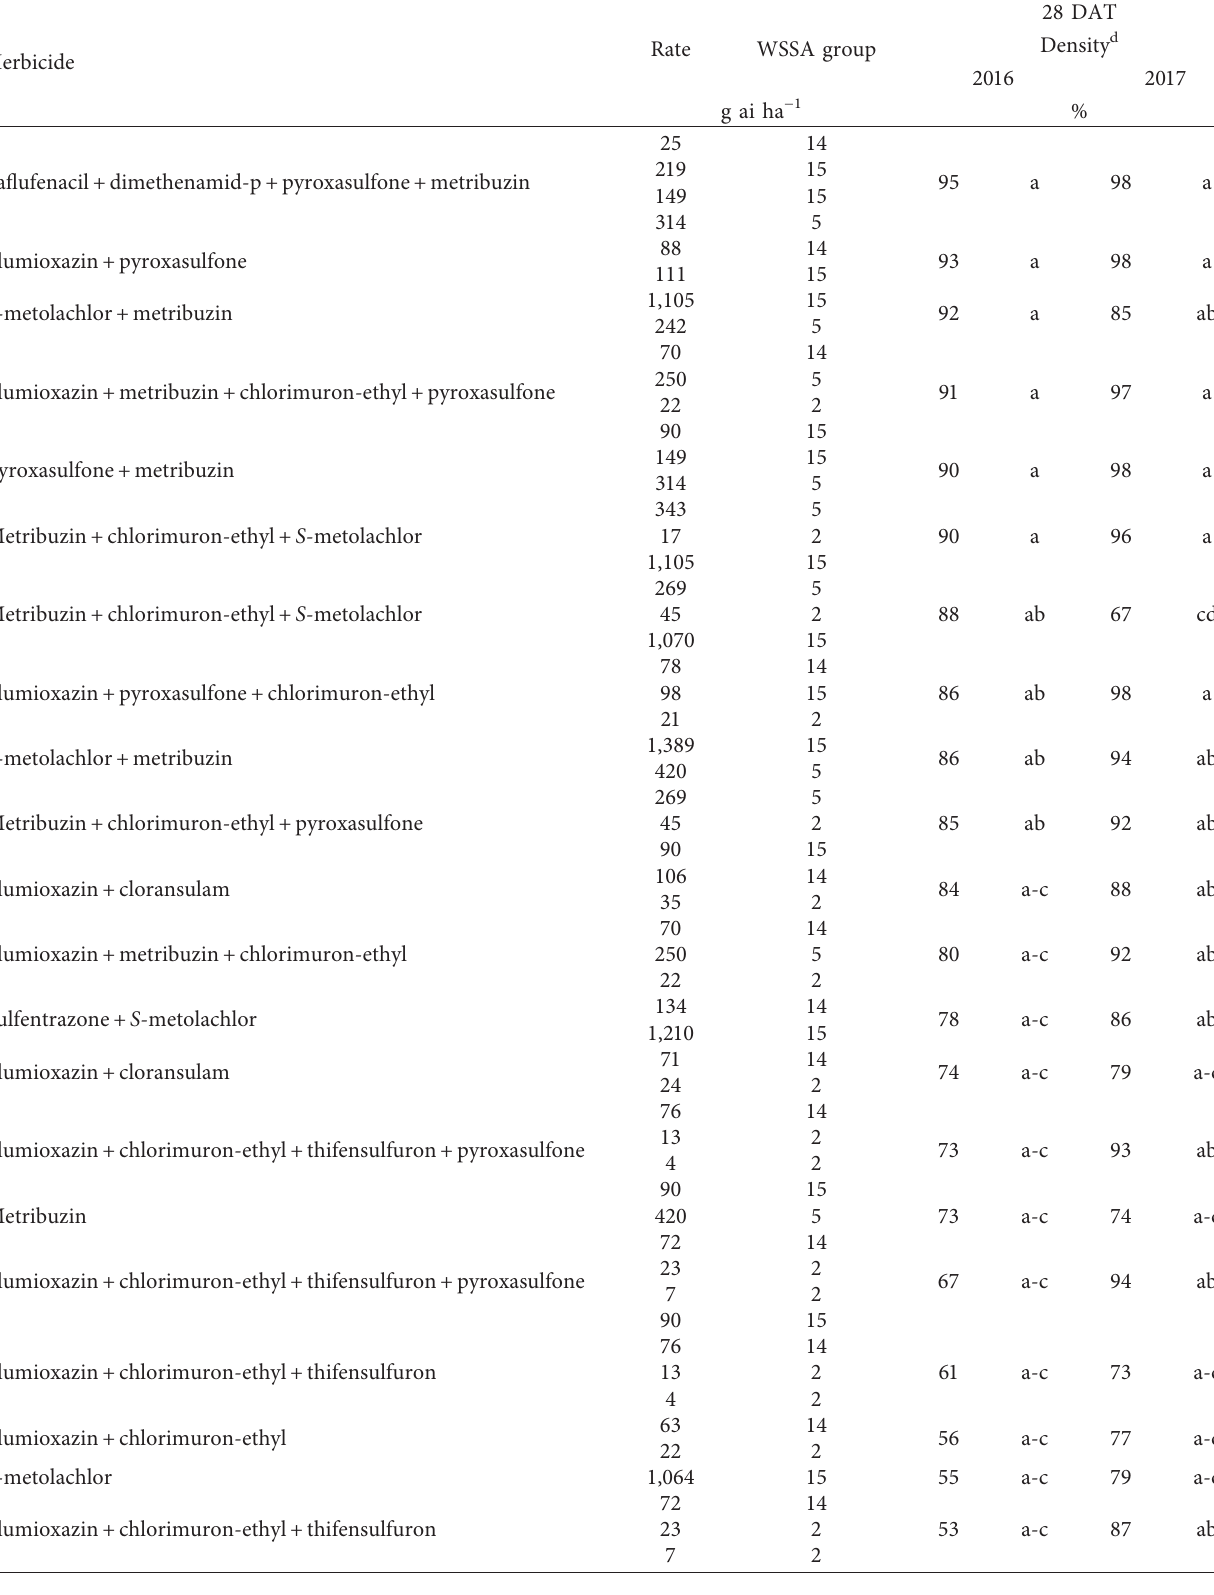
Table 3: Palmer amaranth density reduction following PRE herbicide application in soybean from 12 trials conducted near Crawfordsville and Marion, Arkansas, in 2016 and 2017 a,b,c .